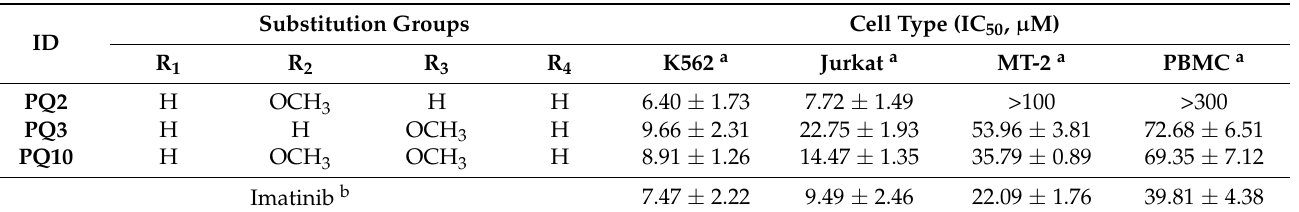
Table 1. The cytotoxic effects of PQ2 , PQ3 , and PQ10 on K562, Jurkat, MT-2 and PBMC cells compared to imatinib.